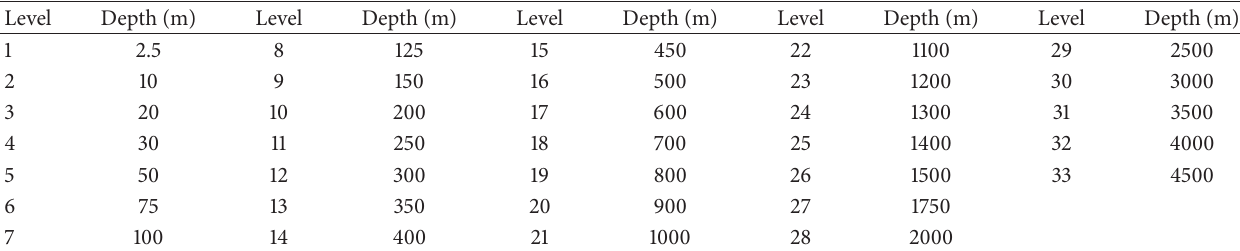
Table 1: The vertical 𝑧 -level grid